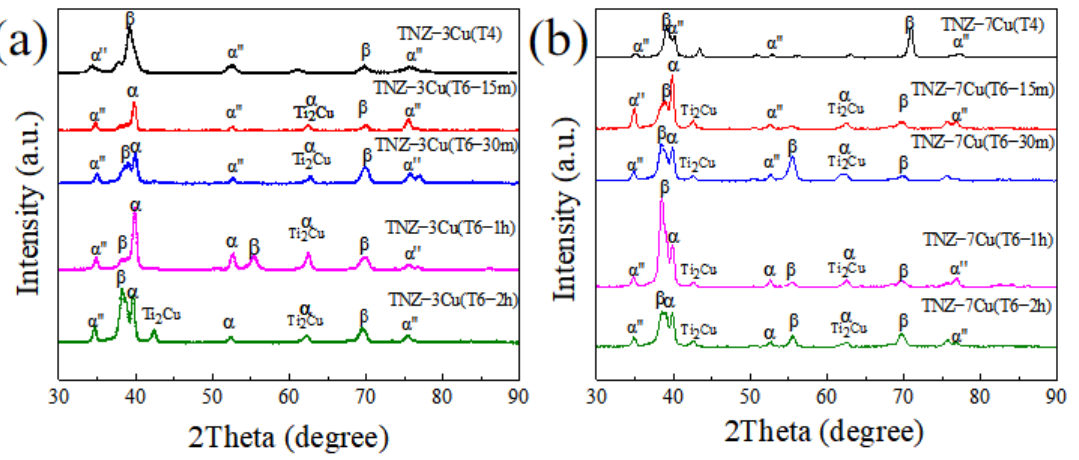
Figure 2. XRD patterns of TNZ-xCu (wt.%, x = 3, 7) after different heat treatments ( a ) TNZ-3Cu; ( b ) TNZ-7Cu.